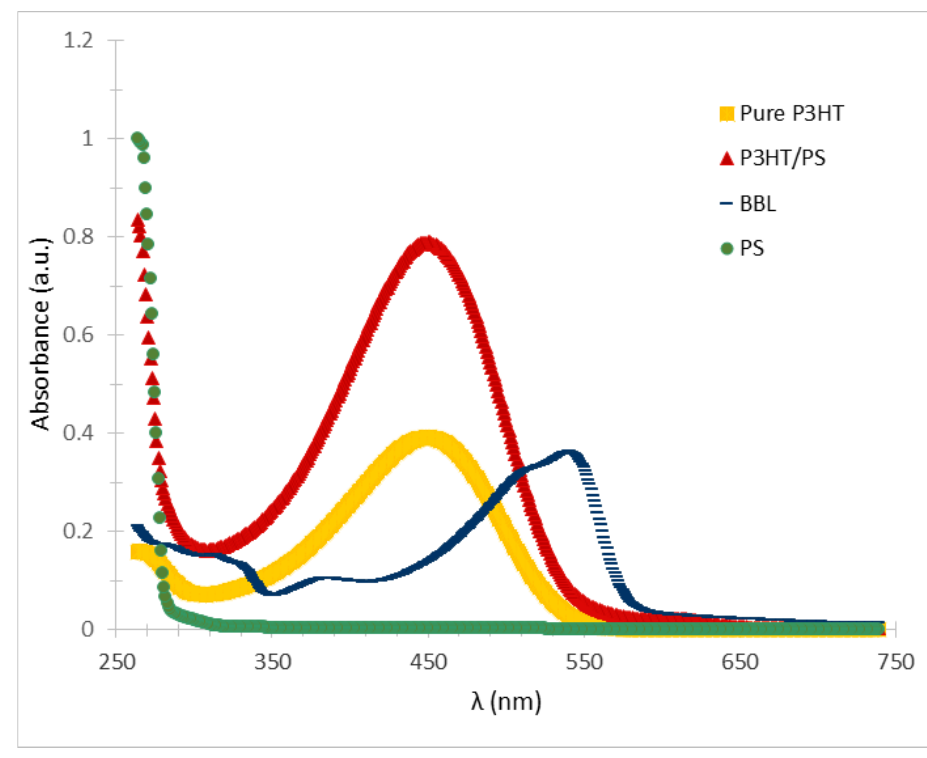
Figure 4. Comparison of the UV/VIS spectra of pure PS (7 wt.%), pure P3HT (2 wt.% in CHCl 3 ), and the P3HT/PS (0.4 wt.%/7 wt.%) blend indicates that adding polystyrene does not change the physical or optical characteristics of P3HT. The BBL solution (0.39 wt.%) exhibits its characteristic broad absorption peak at approximately 540 nm.